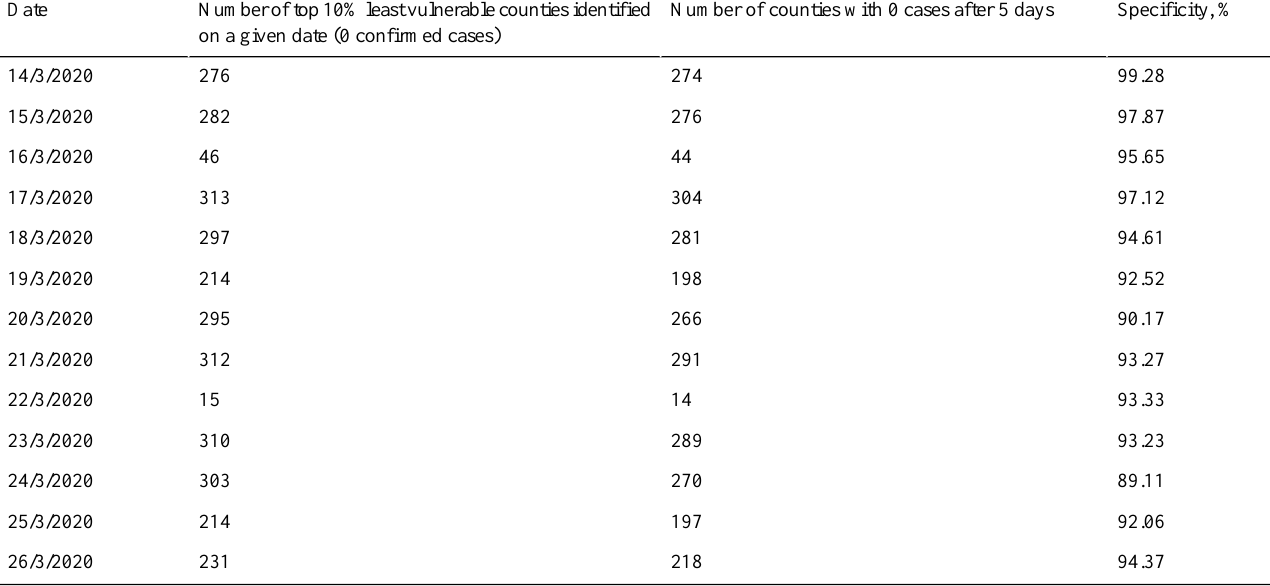
Table 3. Specificity of the three-stage